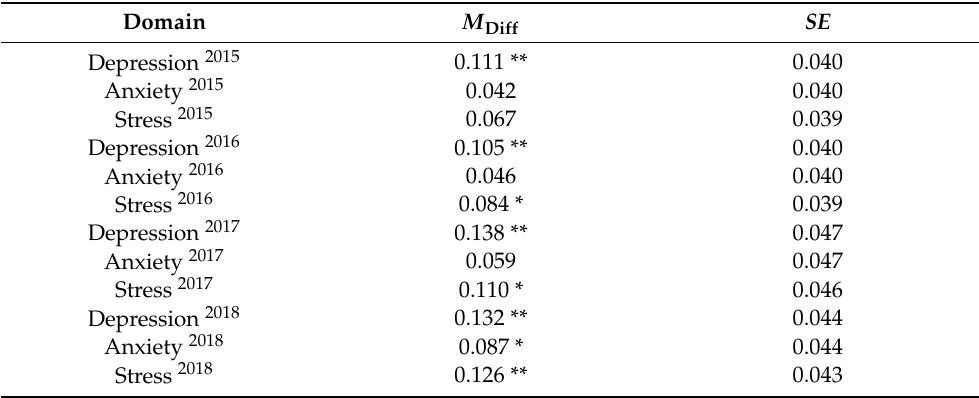
Table 7. Latent means comparison for 2015–2018 compared with the 2014 cohort.